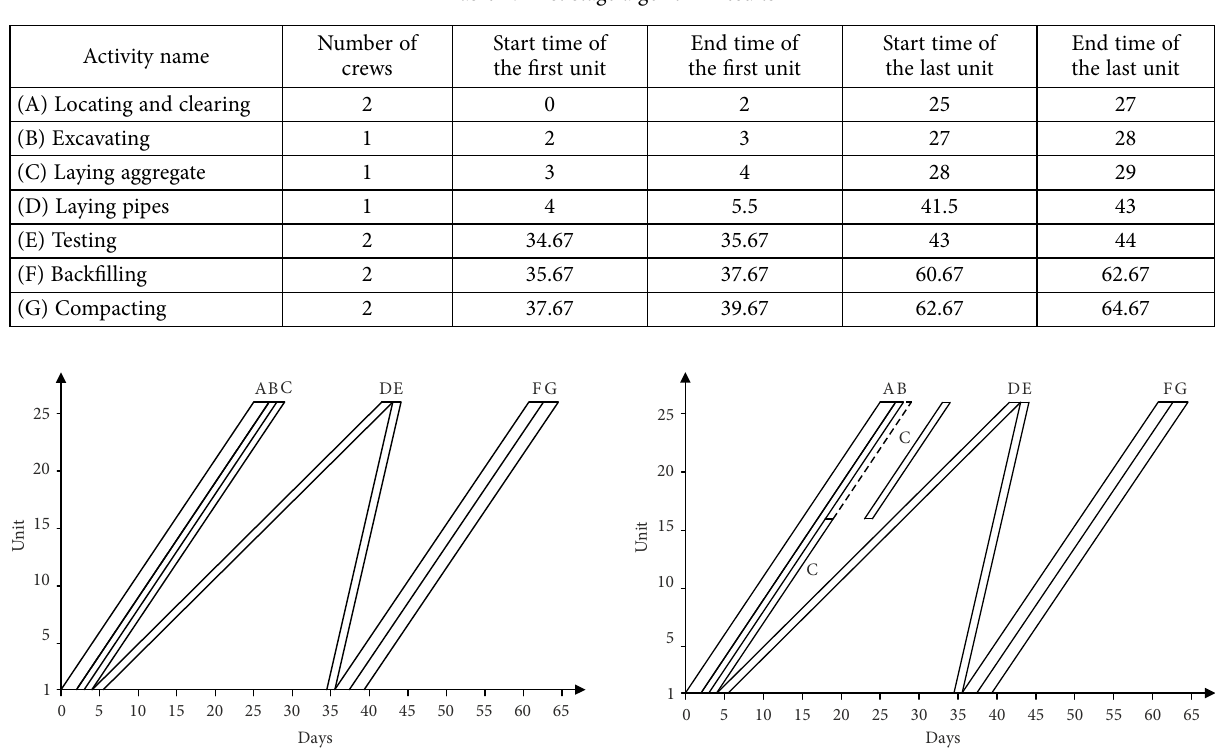
Figure 10. First stage algorithm result Figure 11. Second stage algorithm